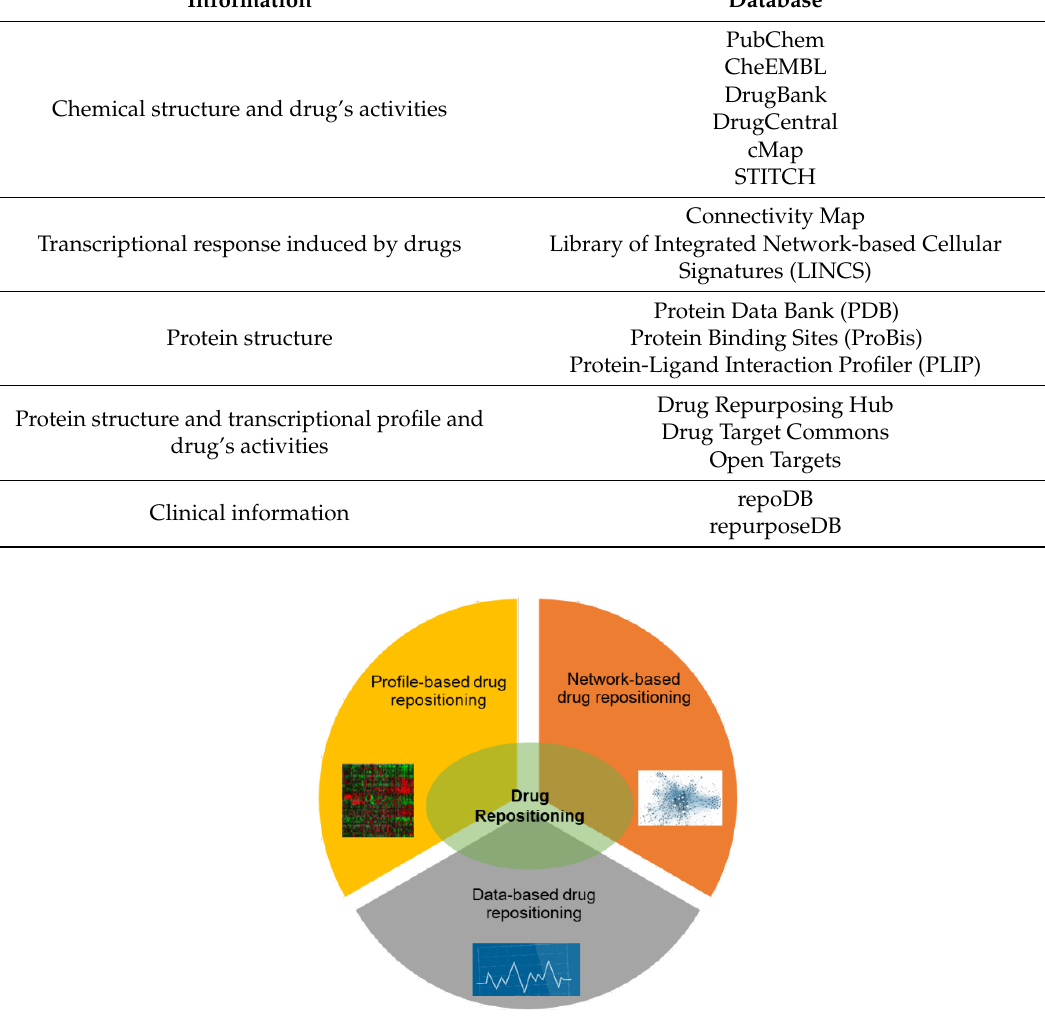
Figure 2. The computational approaches for drug repositioning: profile-based drug repositioning, network-based drug repositioning, and data-based drug repositioning . network-based drug repositioning, and data-based drug